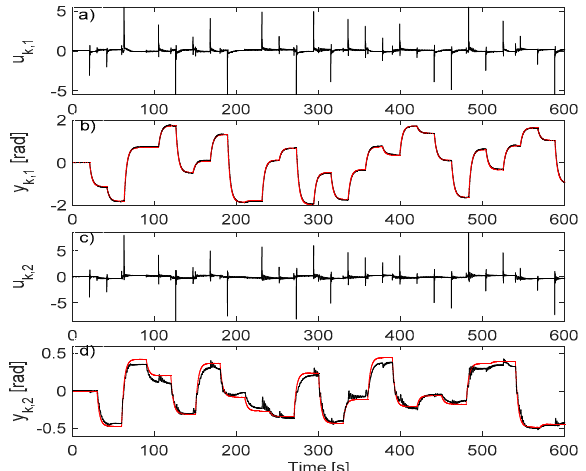
Figure 6. VSFRT NN controller: ( a ) u k,1 ; ( b ) y k,1 (black), y m